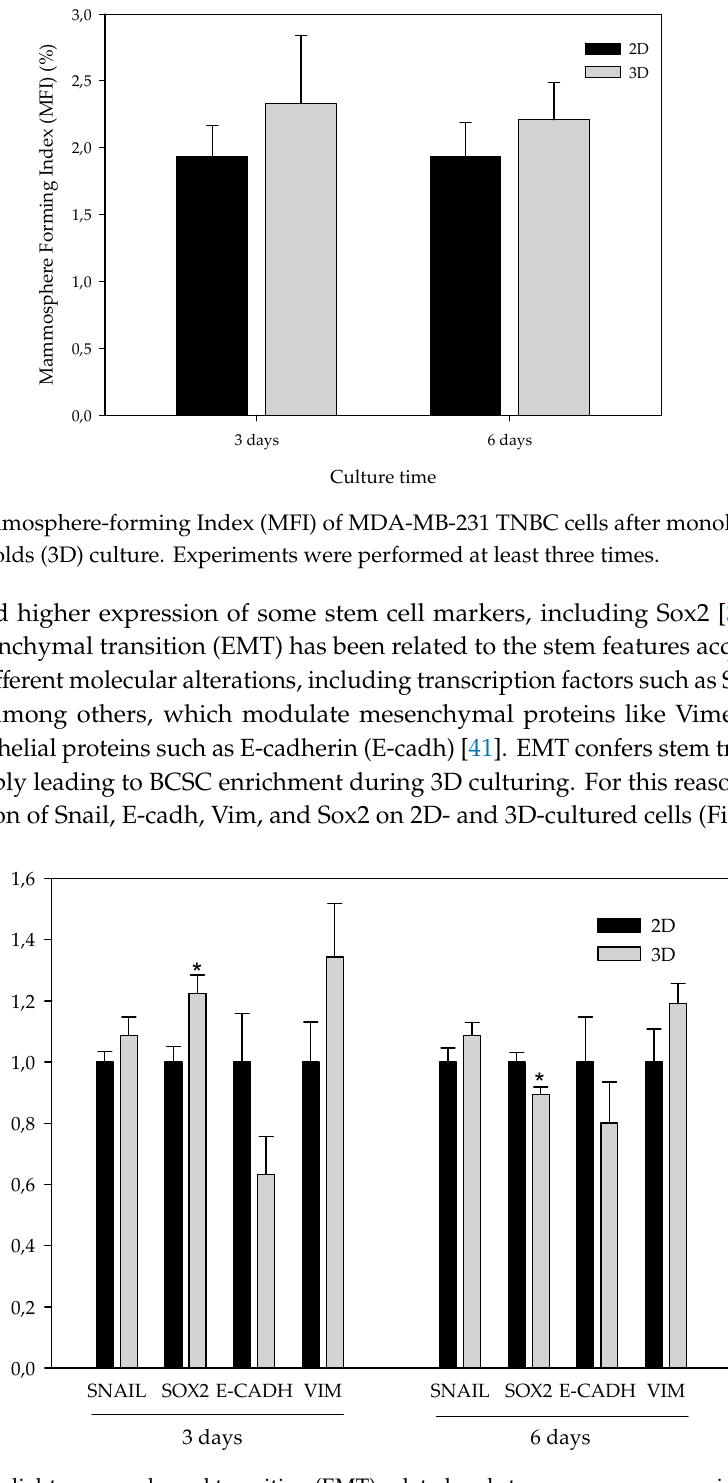
Figure 7. Epithelial-to-mesenchymal transition (EMT)-related and stemness gene expression. Stemness (Sox2) and EMT-related (Snail, E-cadherin, and Vimentin) gene expression of MDA-MB-231 culture in 2D (black bars) and in 3D (grey bars) using 15% PLA ES scaffolds over three days (left) and six days (right). Experiments were performed at least three times. For an easier interpretation, the value obtained for cells cultured in 2D was adjusted to 1 and that of the 3D-cultured cells was calculated based on this. *(p < 0.05) indicates levels of statistical significance.